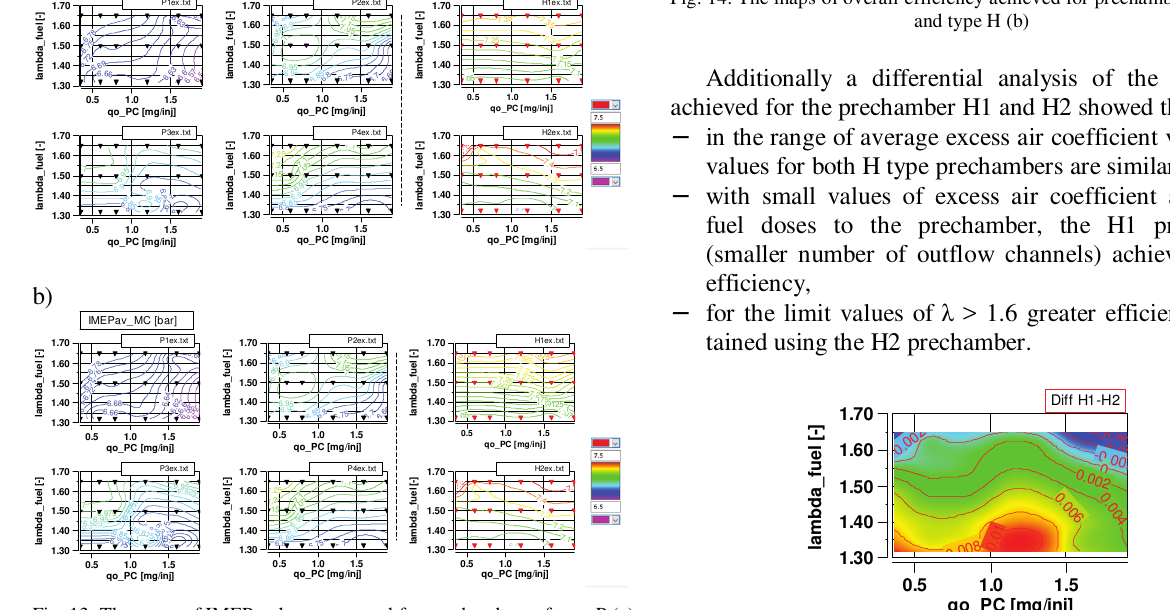
Fig. 13. The maps of IMEP-values measured for prechambers of type P (a) and type H (b) Fig. 15. The differential map of overall efficiency between prechambers of type H (H1–H2) 7. Emission measurement results evaluation The measured concentrations of toxic exhaust com- pounds are presented in the form of specific emission maps for comparison